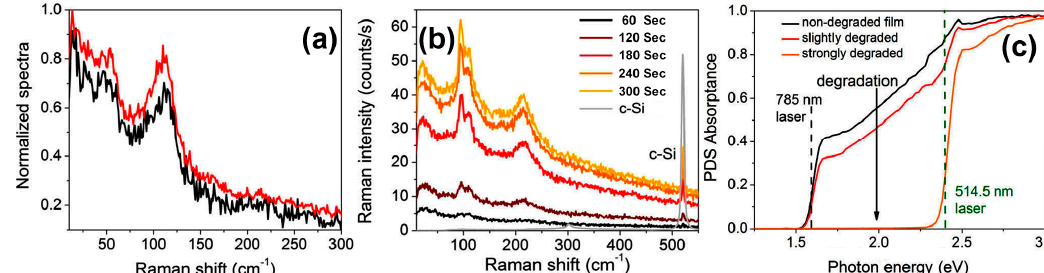
Figure 7. ( a ) Normalized Raman spectra measured at two different positions on a pristine MAPbI 3 layer using a very low excitation laser power of 10 μ W at 514.5 nm; ( b ) Five Raman spectra measured consecutively without any additional delay time at the same position of a MAPbI 3 layer at the excitation wavelength of 514.5 nm in ambient conditions; ( c ) PDS absorption spectra of MAPbI 3 layers at various degradation states. The green and black lines indicate the excitation laser wavelengths used for these experiments (514.5 and 785 nm, respectively) [86]. Copyright © 2015, American Chemical Society.